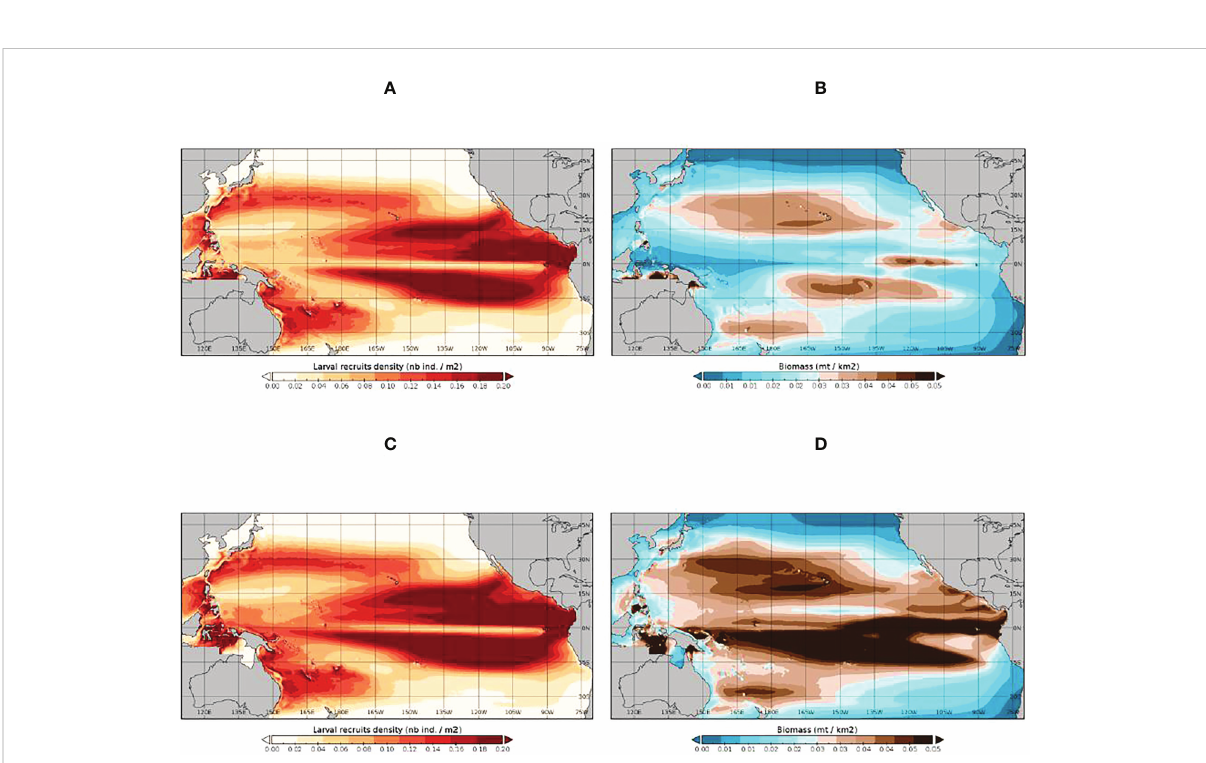
FIGURE 5 The SEAPODYM-simulated 1998-2019 average distribution of bigeye tuna larvae (A, C) and spawning biomass (B, D) under the observed (Fref) level of fi shing (A, B) and under unexploited (F0) conditions (C, D)